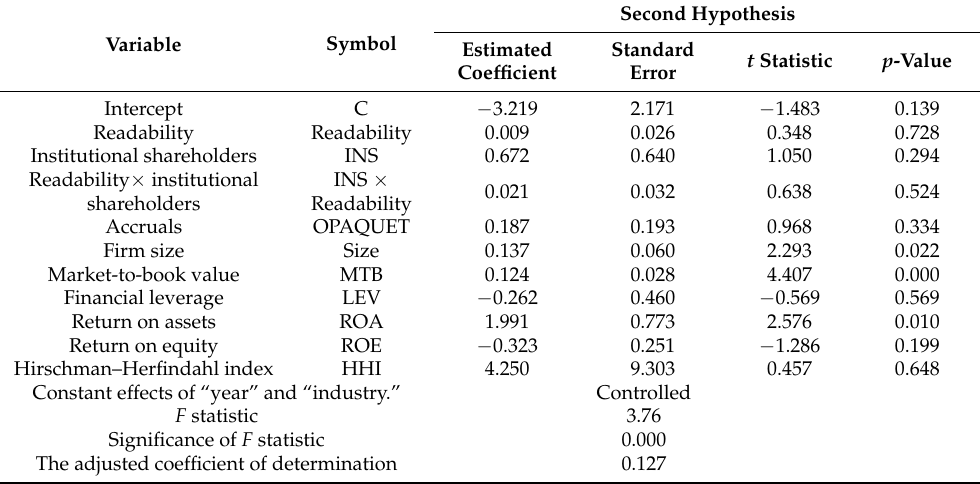
Table 5. Results of the second